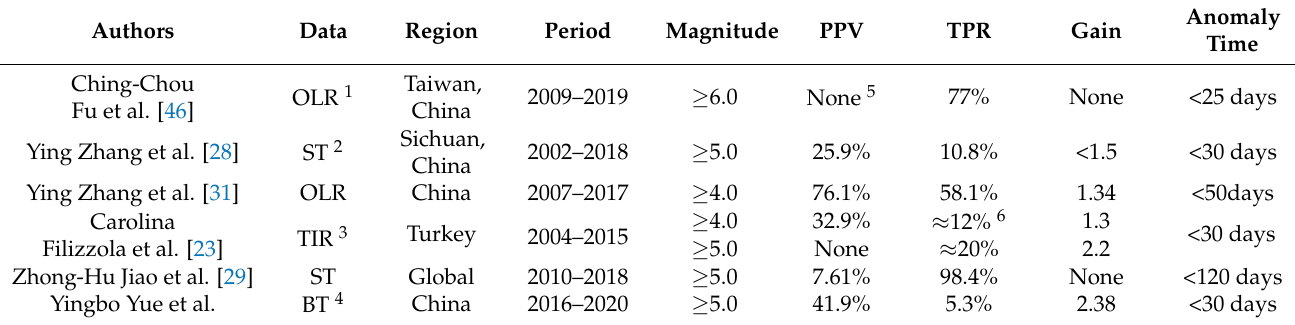
Table 7. The statistical results in previous